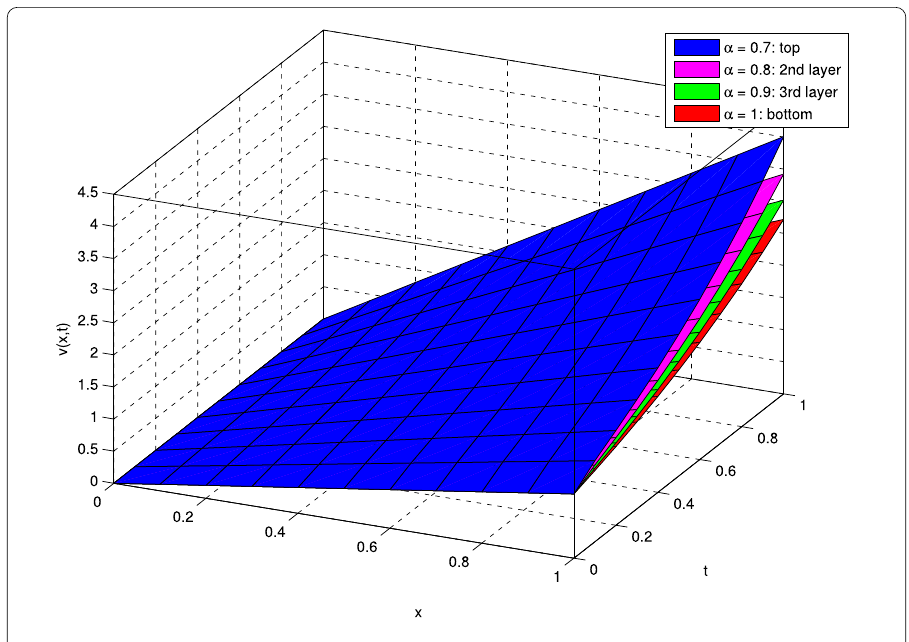
Figure 2 Evolution of surface behavior of LTVIM’s fourth iteration approximate solution of Example 4.1 for x , t ∈ [0,1] and different values of α